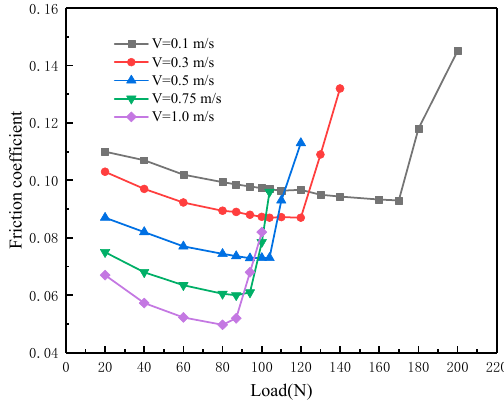
Figure 4. Variation of friction coefficient with load.